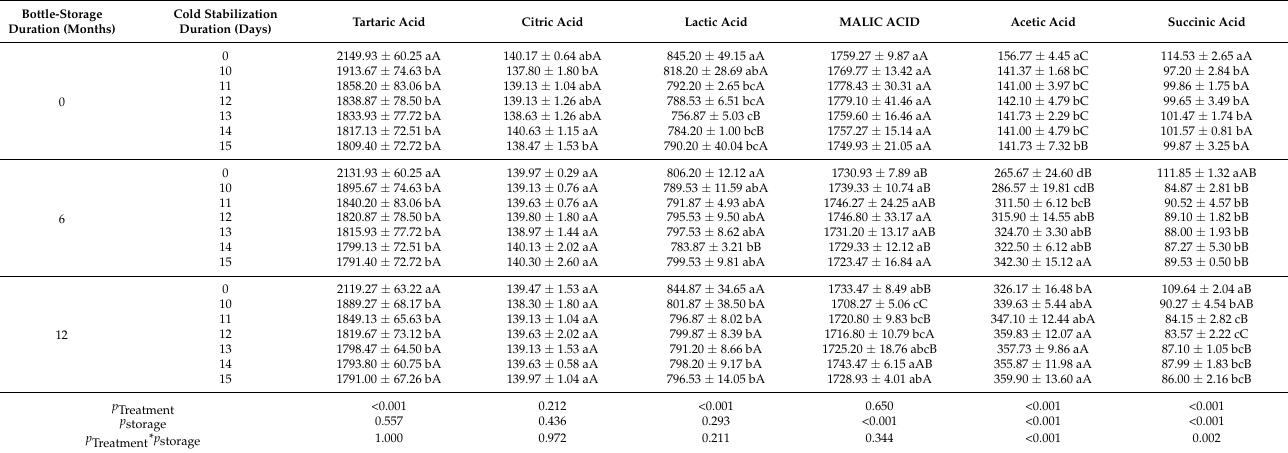
Table 2. Effects of cold treatment duration and bottle-storage duration on concentrations of organic acids (unit: